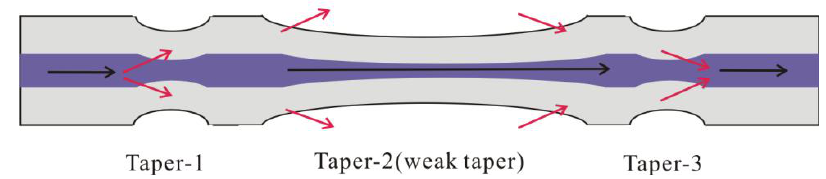
Figure 7. Schematic diagram of the in-line MZI based on three tapers.